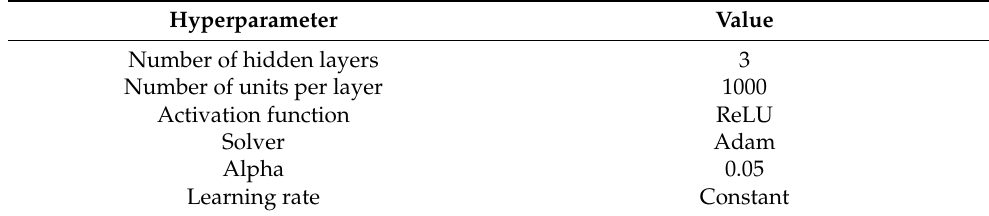
Table 1. Grid search